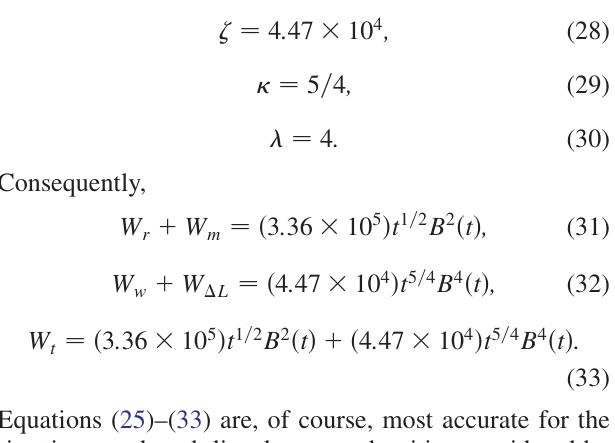
TABLE I. Summary of conductor-energy-loss calculations. These assume a linear-ramp current pulse is applied to a 1-cm-radius solid cylinder of stainless steel. The numerical results are obtained from 1D Lagrangian MHD simulations performed using the MACH2 code [28,30,31]. The losses presented are those obtained at peak current. The expression for W loss that disagrees with the numerical result for many of the conditions considered, but the disagreements occur when the magnitude of this component is significantly less than that of W Eq. (33) agrees to first order with the simulation